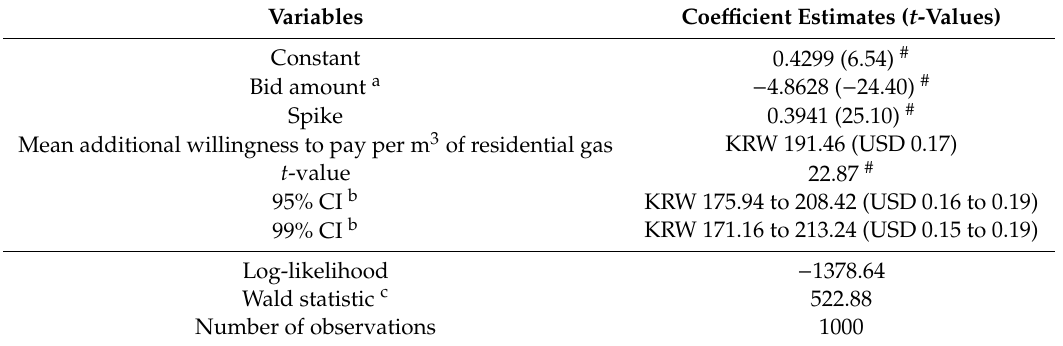
Table 3. Estimation results of the model.